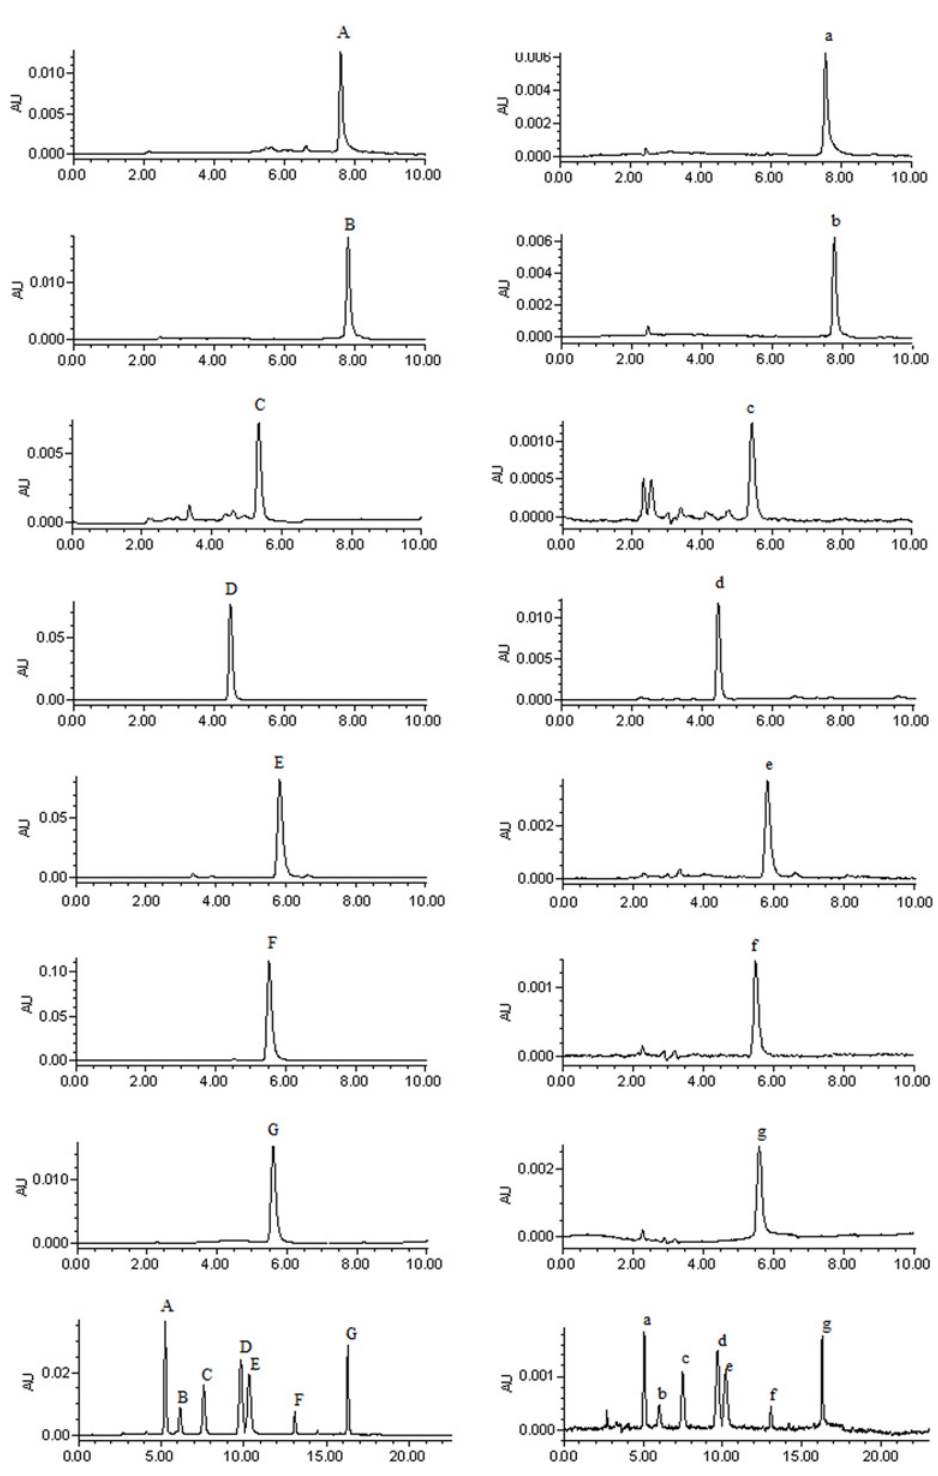
Fig 2. HPLC chromatograms of the seven flavonoids and their equimolar mixture. Notes: A, B, C, D, E, F, and G were chromatograms of the reference solutions of 2 ” - O - β -L-galactopyranosylorientin, 2 ” - O - β -L- galactopyranosylvitexin, orientin, vitexin, isoswertiajaponin, isoswertisin, and 2 ” - O -(2 ”‘ -methylbutanoyl) isoswertisin; a, b, c, d, e, f, and g were chromatograms of the sample solutions of the corresponding compounds across the Caco-2 cell